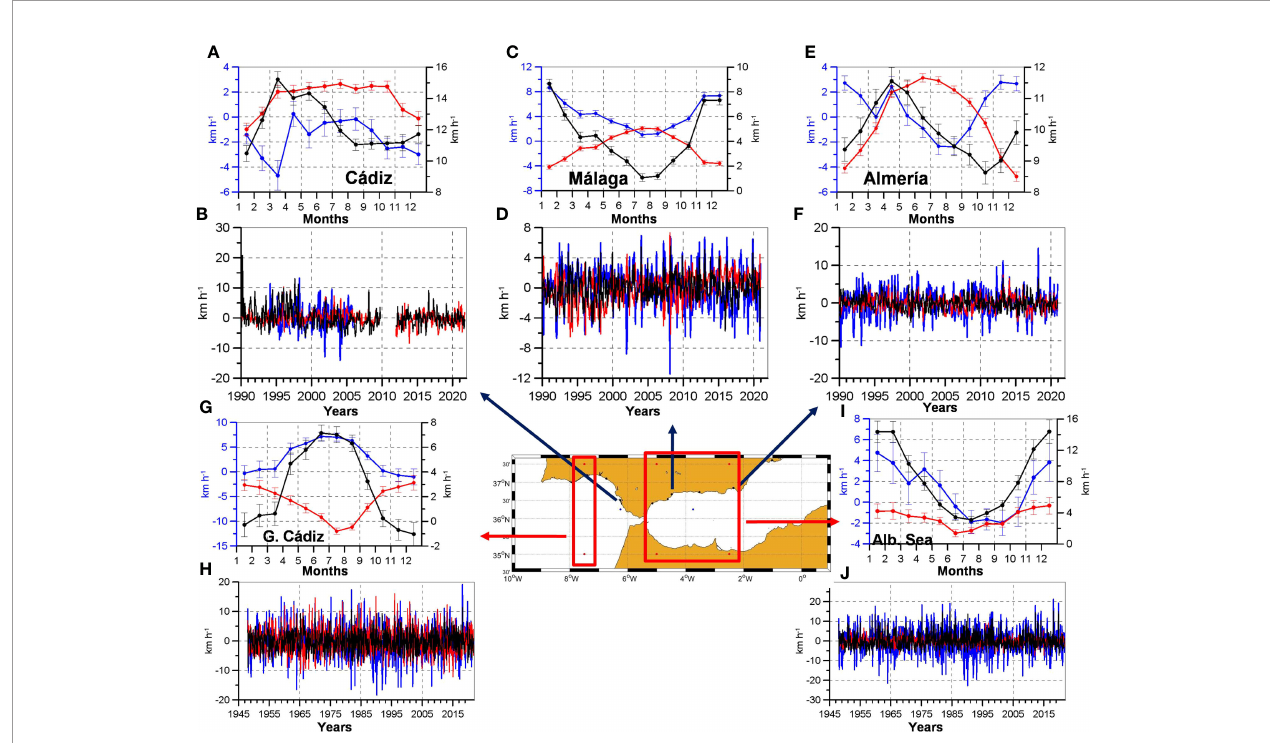
FIGURE 7 | (A, C, E) are the seasonal cycles of west-east component of the wind (blue lines and left axis), south-north component (red lines and left axis) and the wind intensity (black lines and right axis) for the meteorological stations of Ca ́ diz, Ma ́ laga, and Almer ı ́ a. (B, D, F) are the corresponding time series of anomalies. (G, I) are the wind seasonal cycles for the regions of Gulf of Ca ́ diz and the Albora ́ n Sea, using the reanalysis data. (H, J) are the corresponding time series of anomalies.